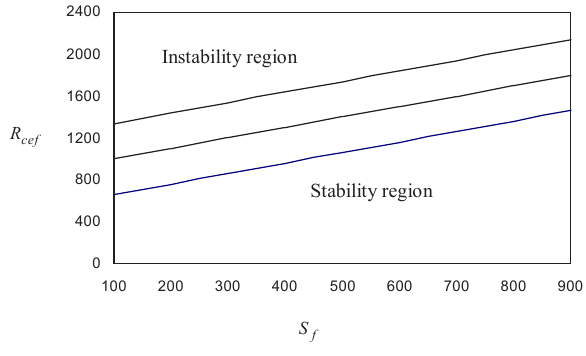
Figure 4: The variation in the critical thermal Rayleigh number R with the solute gradient S Fig. 4. The variation in the critical thermal Rayleigh number gradient f S